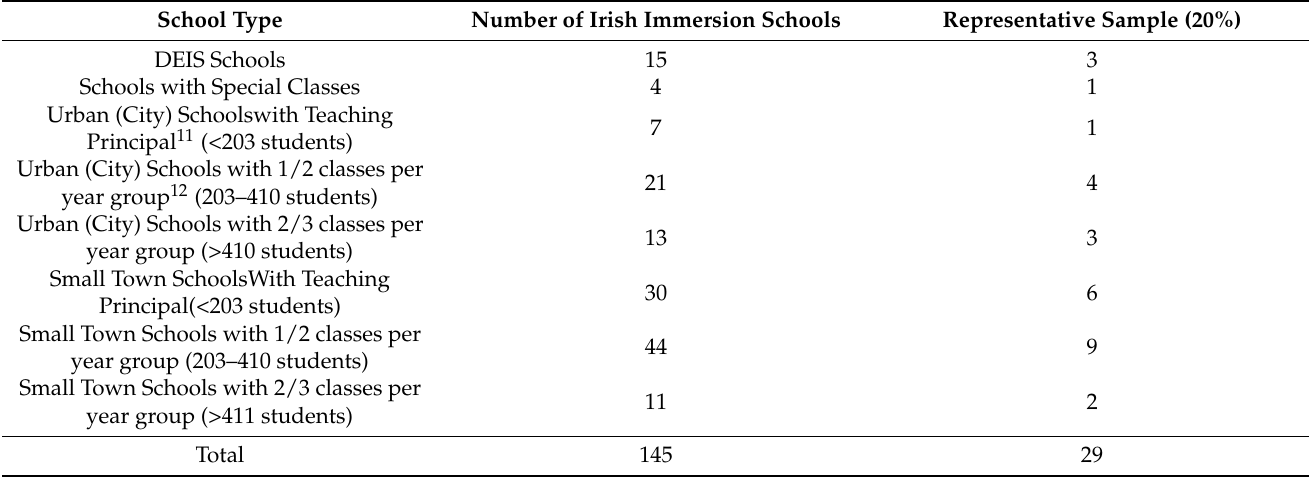
Table 1. The representative sample of Irish immersion schools included in this